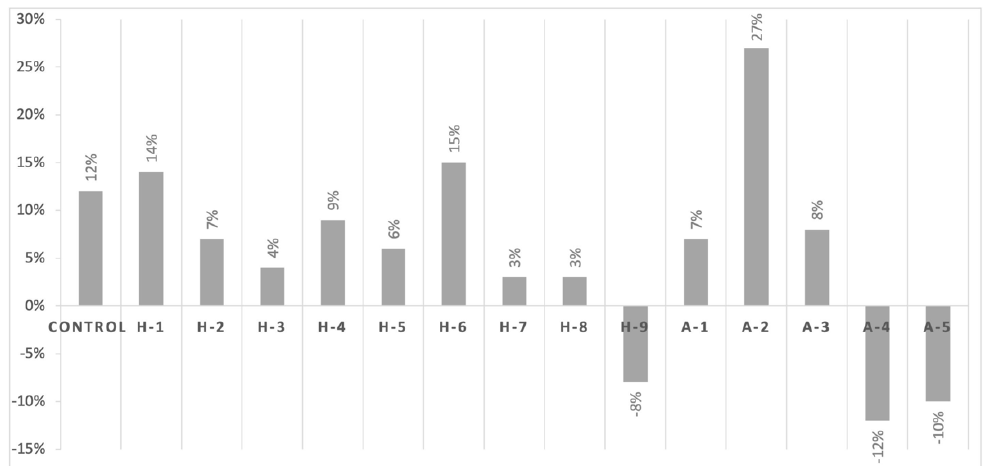
Figure 2. Percentage increase or decrease in the diameter of the inhibition zone when icariin was used in combination with AmoxyClav. All values are expressed in comparison with the control strain. Complete descriptions of the abbreviated strain names on the x -axis can be found in Table 1.